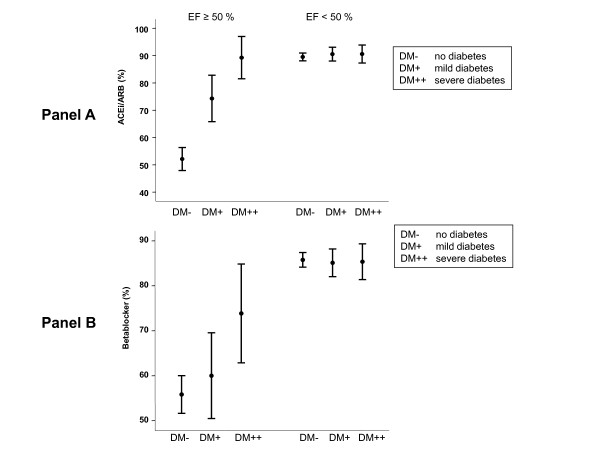
Percentage of patients without diabetes (DM-), with mild diabetes (DM+, on diet or taking oral anti-hyperglycaemic drugs) and with severe diabetes (DM++, insulin-dependent diabetes) receiving different drugs (mean, 95% confidence interval). Panel A shows prevalence of treatment with ACE inhibitors or angiotensin receptor blockers, panel B shows therapy with beta-blockers. Data are separated by ejection fraction: Left side preserved ejection fraction (EF ≥ 50%), right side reduced ejection fraction (EF <50%).